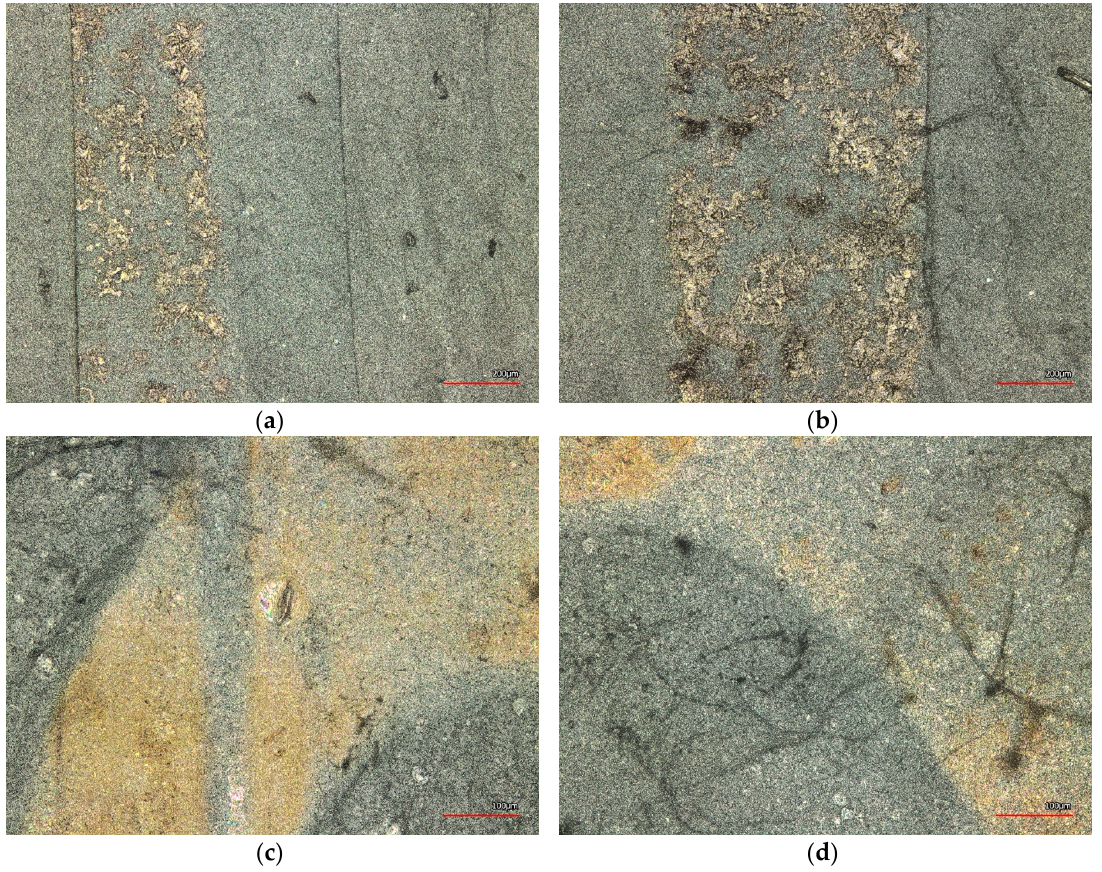
Figure 7. CLSM images of the ultrasonic welding seams prepared with different anvil wheels and pressures: ( a ) T-stitch welding with pressure 60% = 90 bar and 600 W; ( b ) T-stitch welding with pressure 70% = 105 bar and 700 W; ( c ) omega welding with pressure 65% = 97.5 bar and 750 W; ( d ) omega welding with pressure 65% = 97.5 bar and 750 W at another position. The scales differ due to the different seam widths.